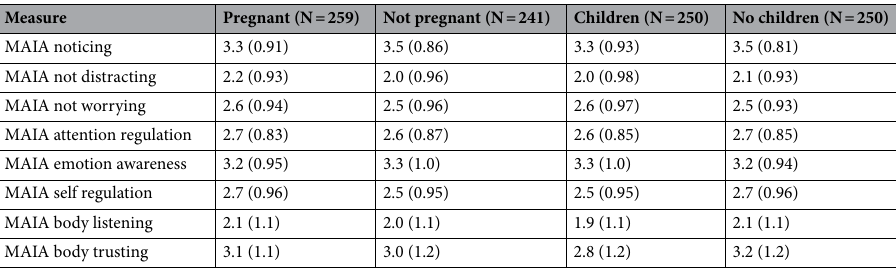
Table 7. Means (SD) of pregnant and non-pregnant women and those with and without children for the MAIA subscales. Higher scores indicate higher levels of awareness. MAIA multidimensional assessment of interoceptive awareness.